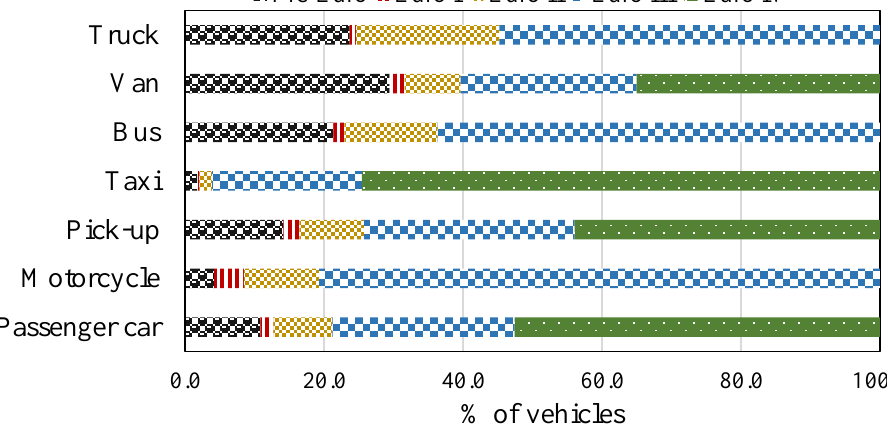
Figure 4. Proportion of different vehicle technologies for each vehicle type in Bangkok.